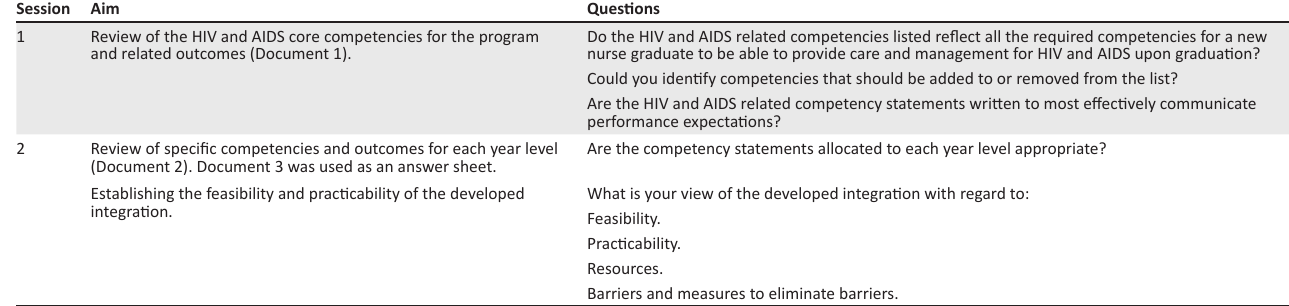
TABLE 2: Process followed in the